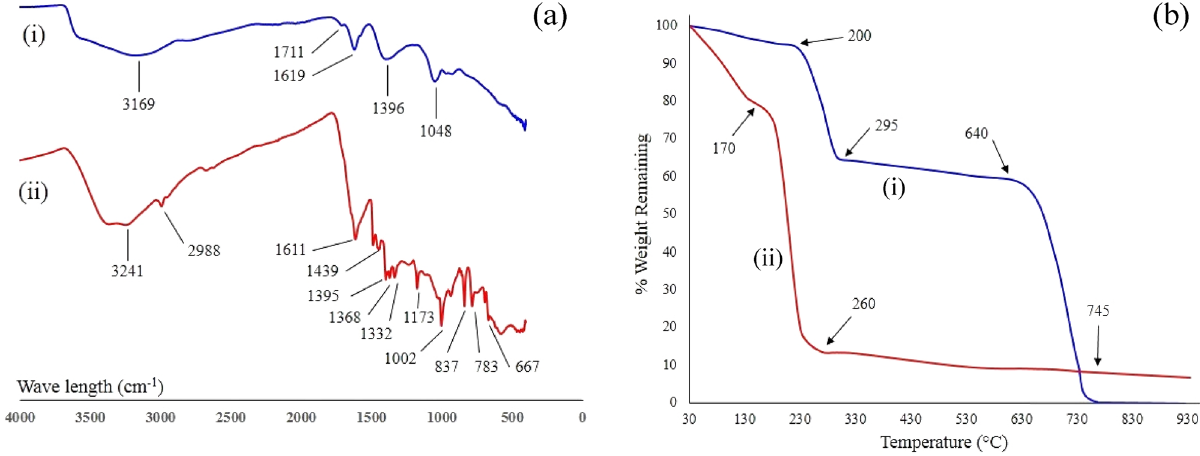
Figure 2. ( a ) FTIR spectra of (i) GO and (ii) RGO samples and ( b ) TGA of thermographs of (i) GO and (ii) RGO wrinkling. Figure 1d presents a representative TEM sample showing well dispersed and transparent sheets of GO. Stability measurements for these samples gave an absolute zeta potential of 43.4 mV (Fig. 1b). Typically, suspensions with absolute zeta potential values greater than 30 mV are physically stable, while suspensions below 20 mV have limited stability, and suspensions below 5 mV experience rapid aggregation. Thus, the GO- based aqueous nanofluid is physically stable and it was only after 6 months its zeta potential dropped down to 30.3 mV. In the case of the RGO-based aqueous nanofluid, the surface features of the flakes were different as seen in FESEM image presented in Fig. 1e and TEM image shown in Fig. 1f. The change in texture and surface features supports the results of the following characterisation studies that indicate oxygen-bearing functional